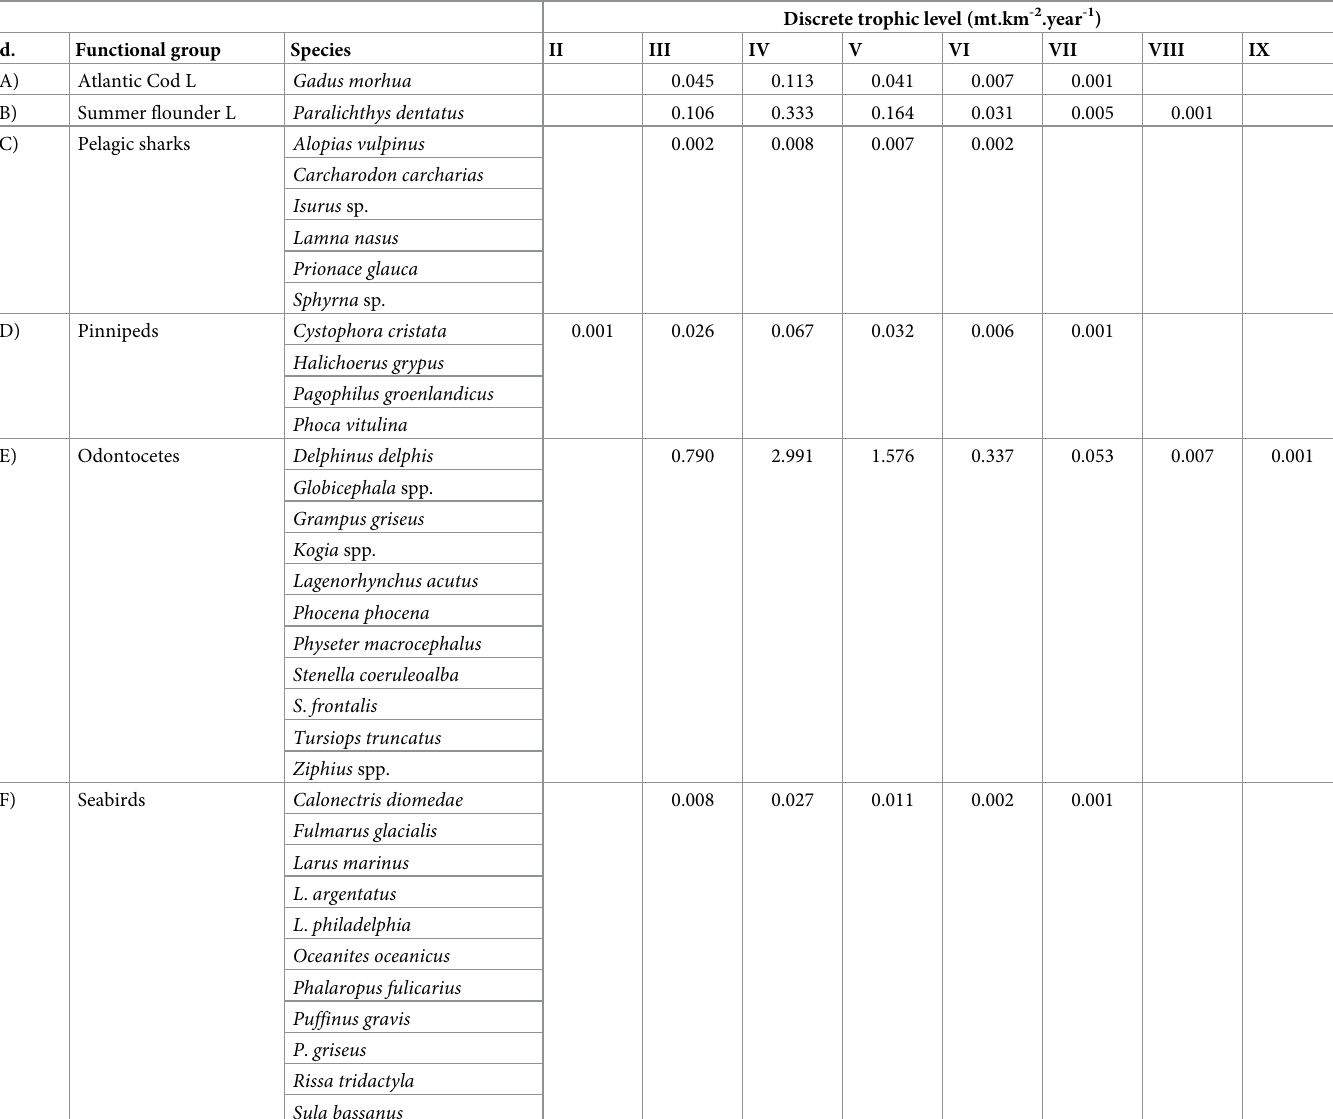
Table 4. The difference in trophic level decomposition ( sensu Lindeman) between the CAB and RAB models.